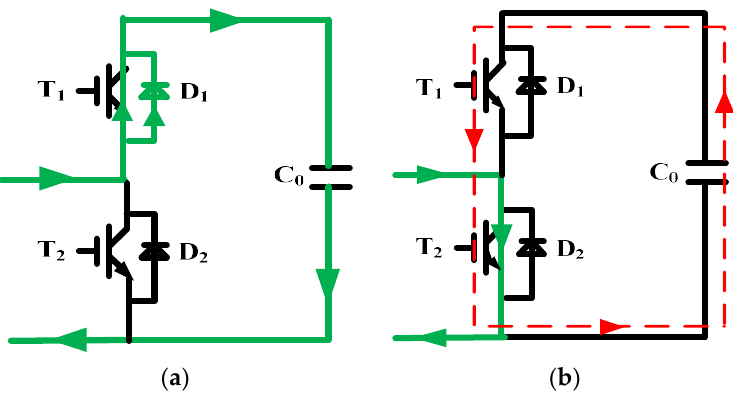
Figure 2. Current path when T 1 is short-circuit with i arm > 0. ( a ) S = 1. ( b ) S = 0.